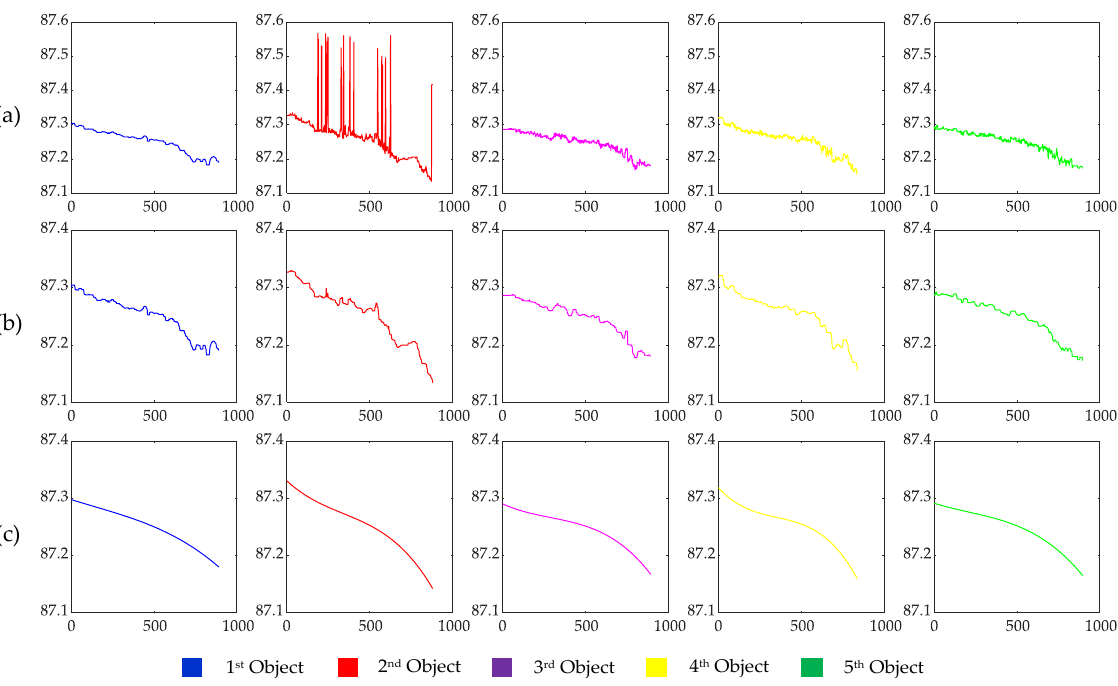
Figure 8. The planar trajectories of moving objects in the world coordinate system in which the ordinate is X (m), and the abscissa is Y (m).